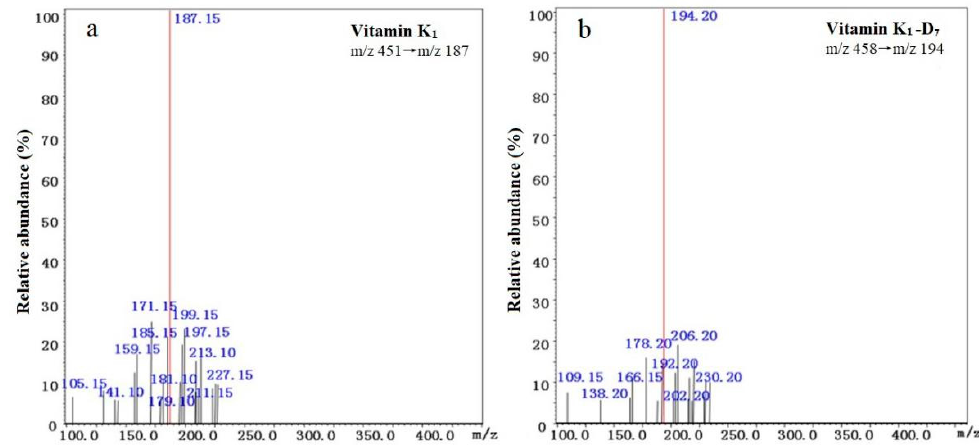
Figure 3. Tandem mass spectra of vitamin K 1 ( a ) and vitamin K 1 -D 7 ( b ).